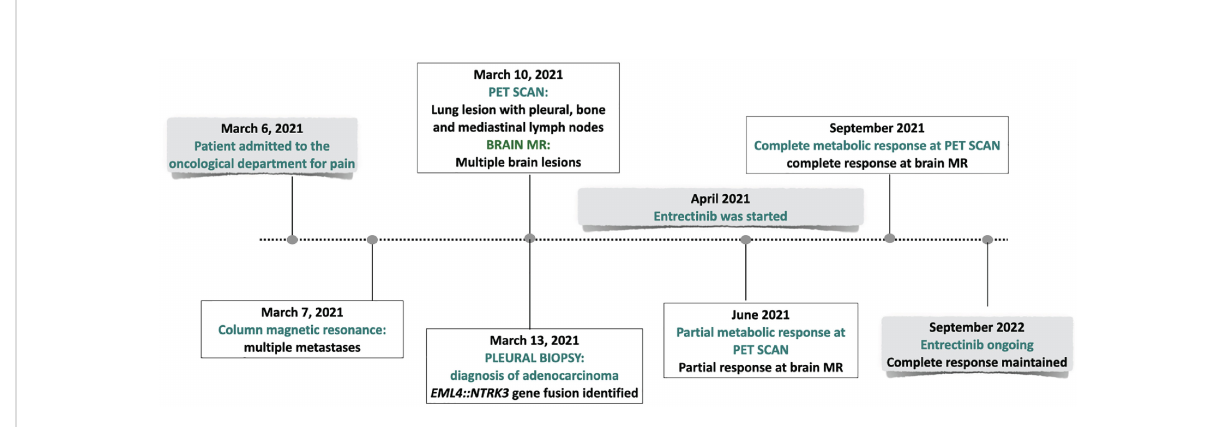
FIGURE 4 Timeline showing the clinical history of the